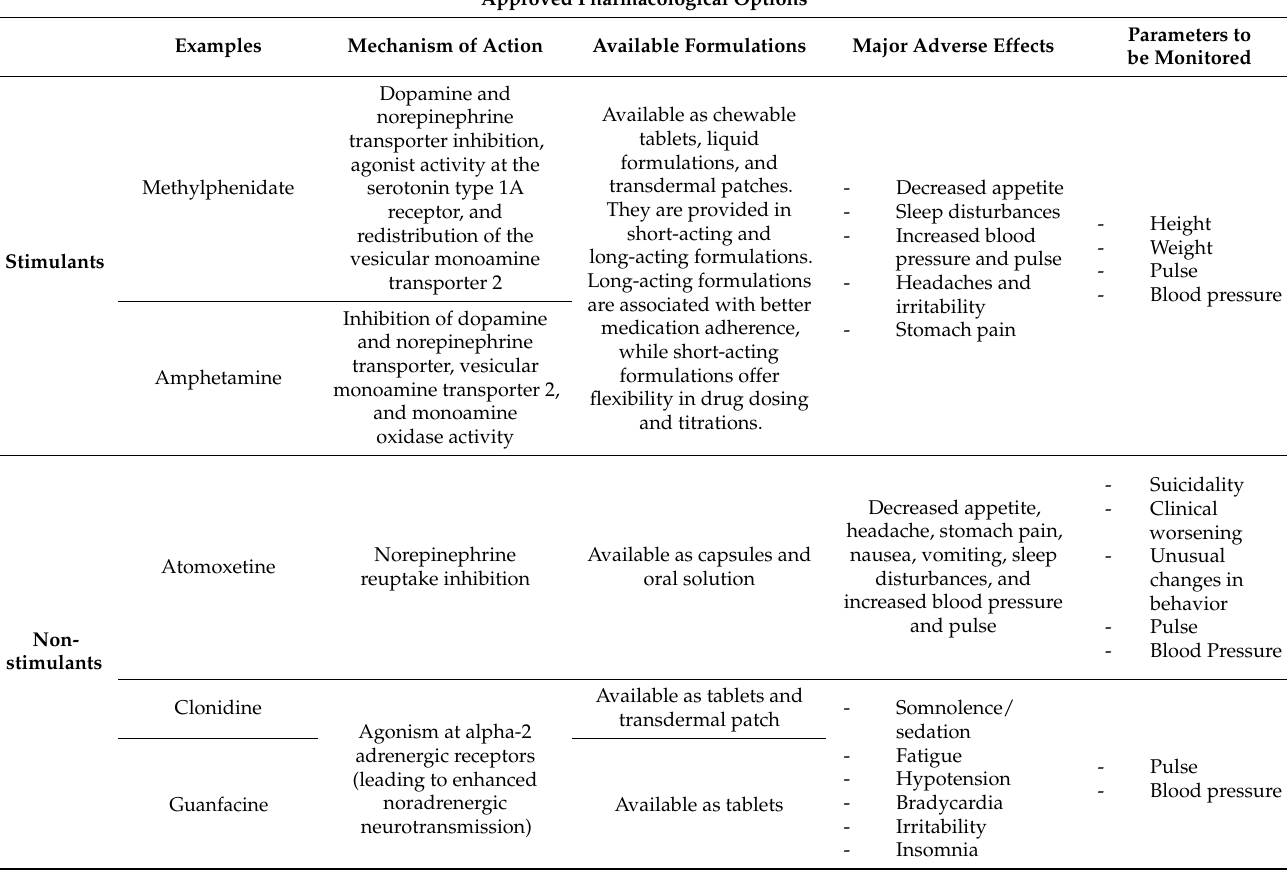
Table 2. Essential information concerning approved ADHD